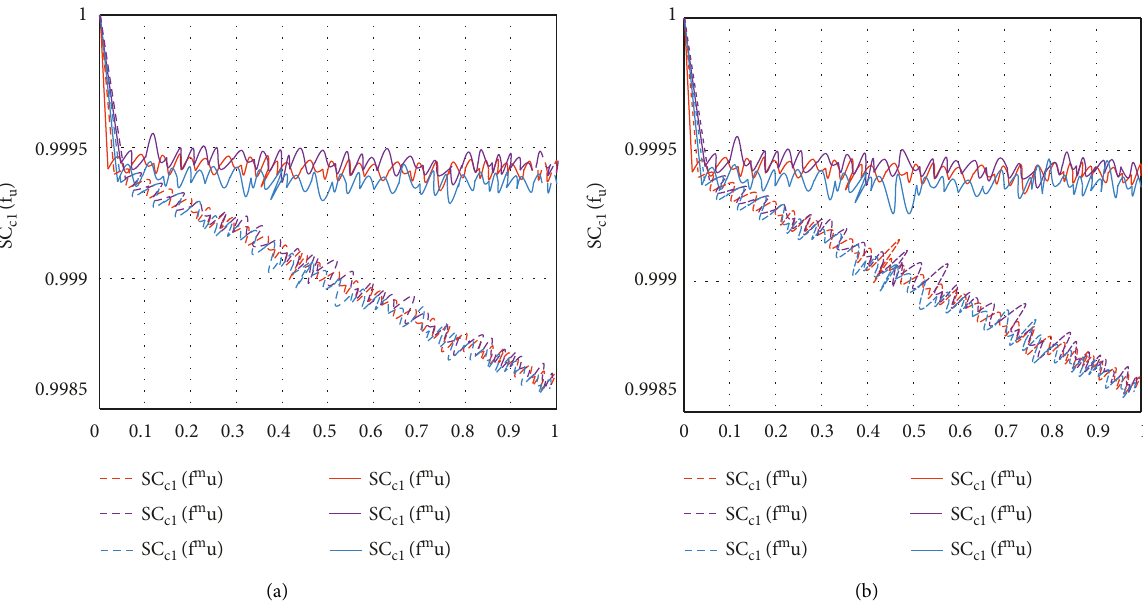
Figure 3: (a) SC ( f ) curve and w U ( 0 , 1 ) increase with the intensity of the reel noise: the additive noise is represented by a cool color, c 1 n ∼ and the multiplicative noise is represented by a warm color. (b) The SC c